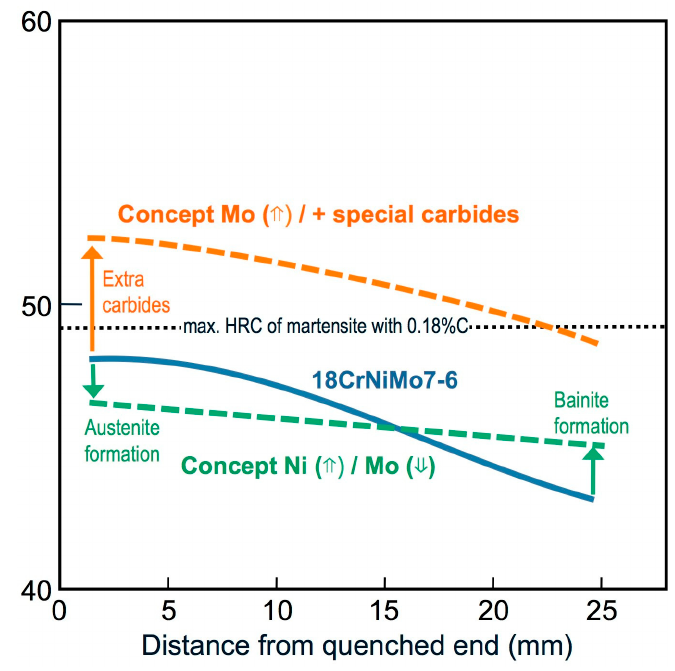
Figure 9. Effect of alloy modifications on hardenability as compared to standard 18CrNiMo7-6